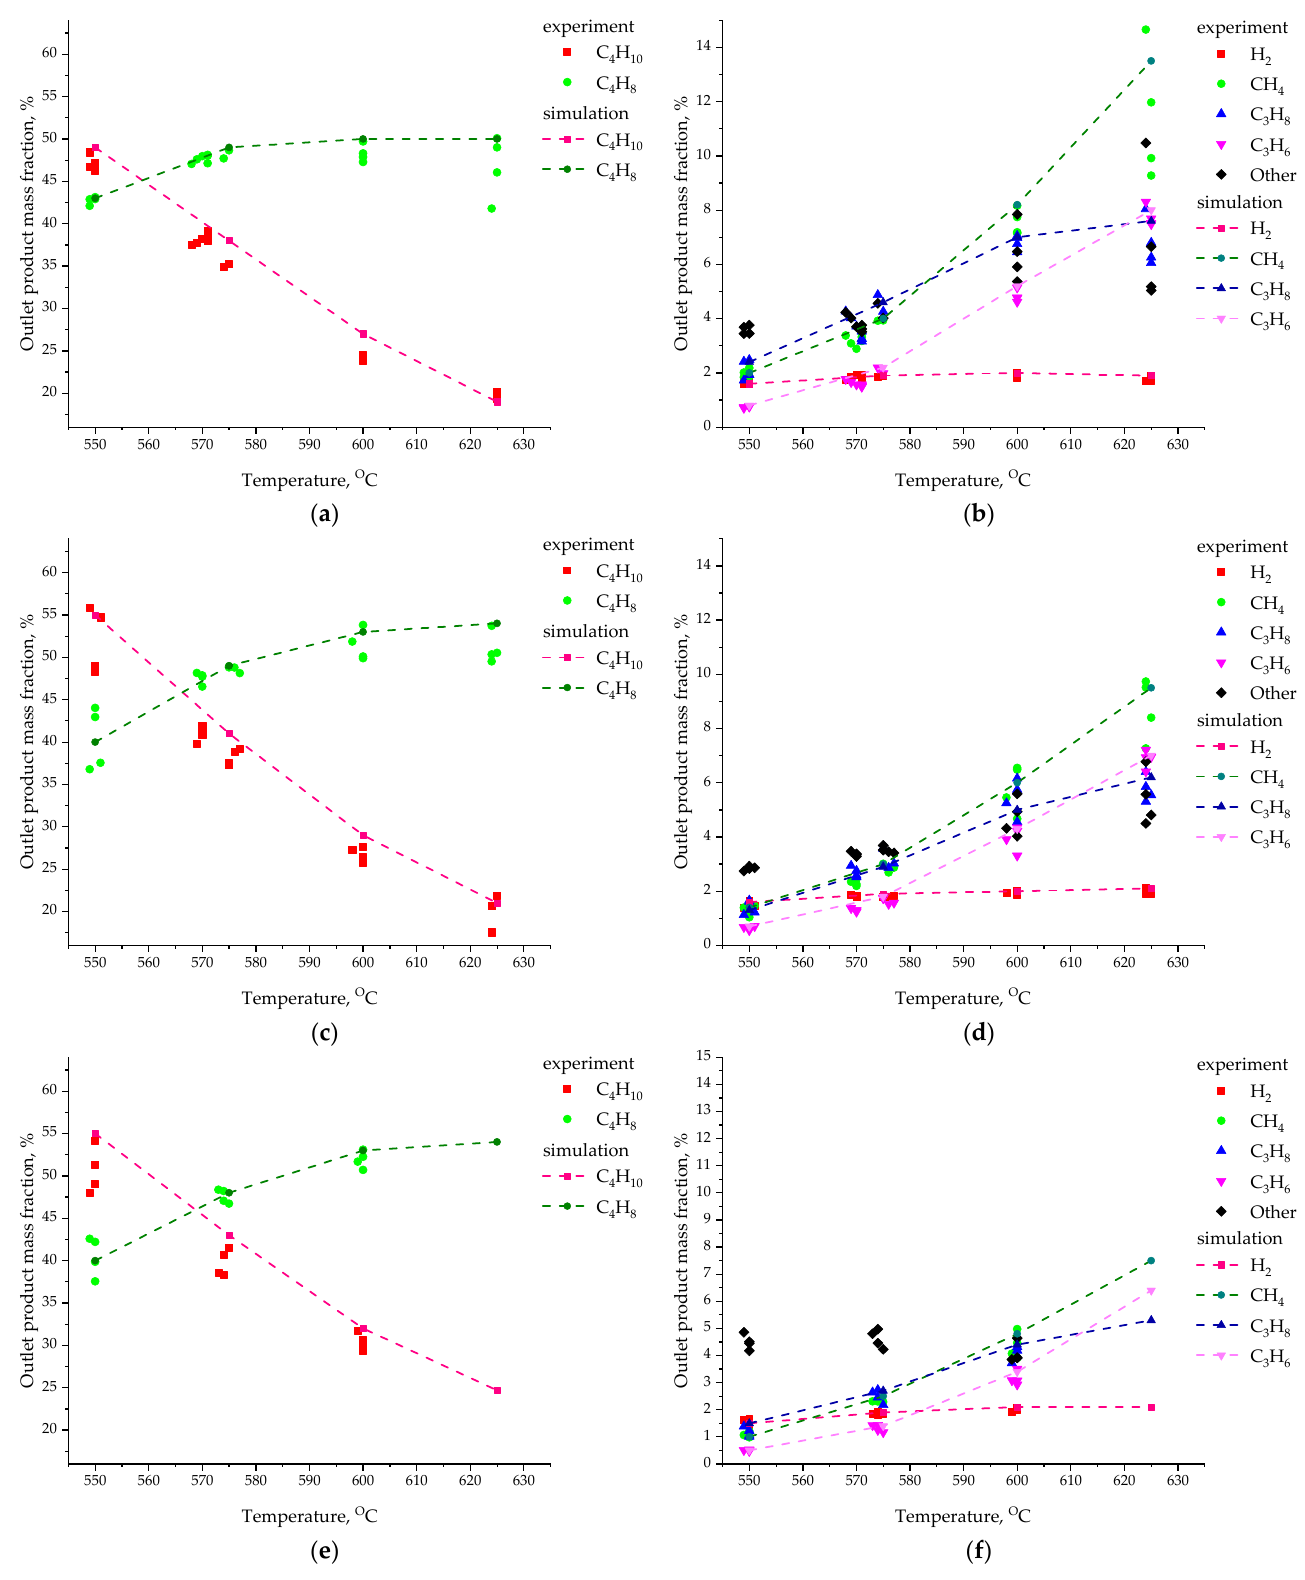
Figure 9. The mass fraction of reaction products for the case of catalyst mass of 125 g: ( a ) C 4 H 10 and C 4 H 8 at v = 0.008 m/s; ( b ) H 2 , CH 4 , C 3 H 8 , C 3 H 6 at v = 0.008 m/s; ( c ) C 4 H 10 and C 4 H 8 at v = 0.012 m/s; ( d ) H 2 , CH 4 , C 3 H 8 , C 3 H 6 at v = 0.012 m/s; ( e ) C 4 H 10 and C 4 H 8 at v = 0.016 m/s; and ( f ) H 2 , CH 4 , C 3 H 8 , C 3 H 6 at v = 0.016